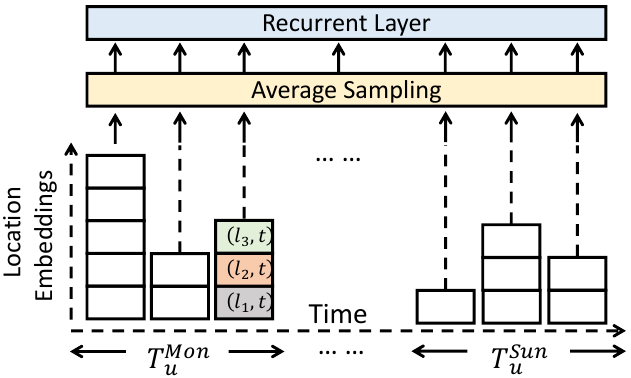
Figure 5. The average sampling strategy, designed to deal with long-time-period mobility